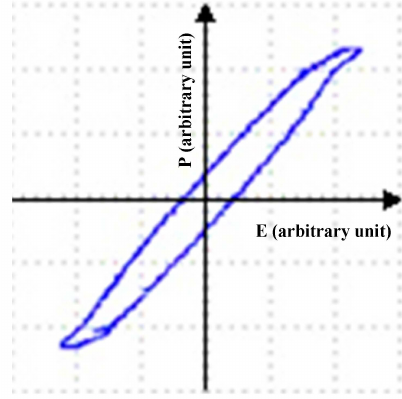
Figure 7. Printed PVDF hysteresis loop.